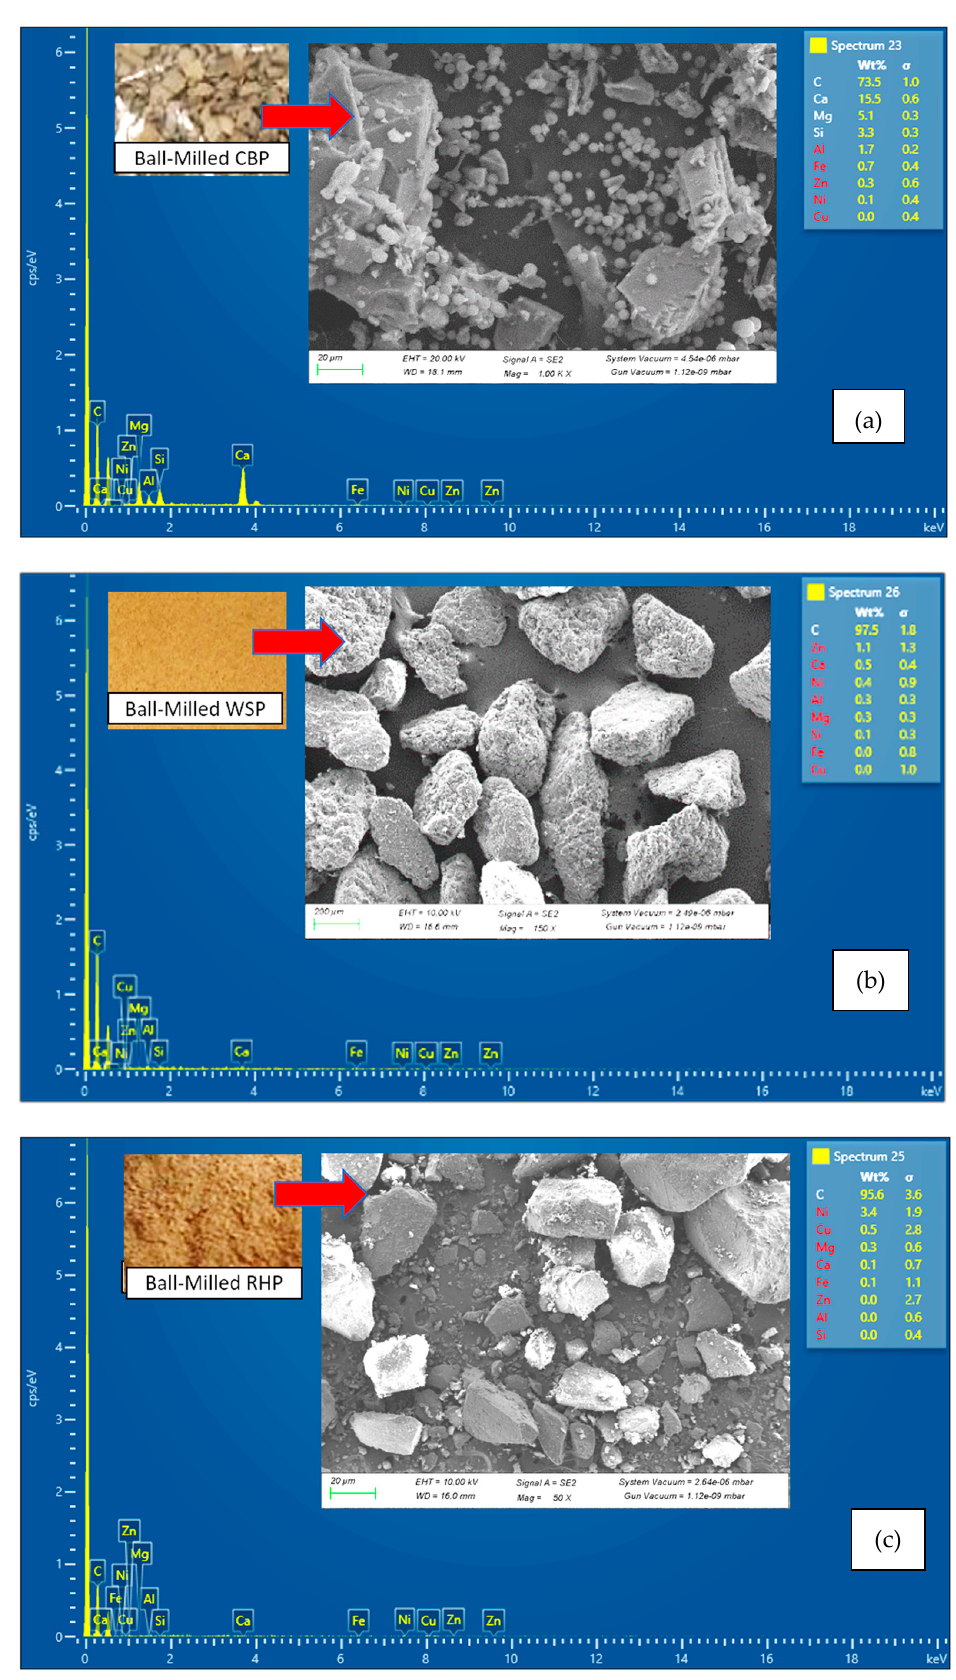
Figure 1. FESEM image and their corresponding EDS spectrum for ( a ) CBP ( b ) WSP ( c )